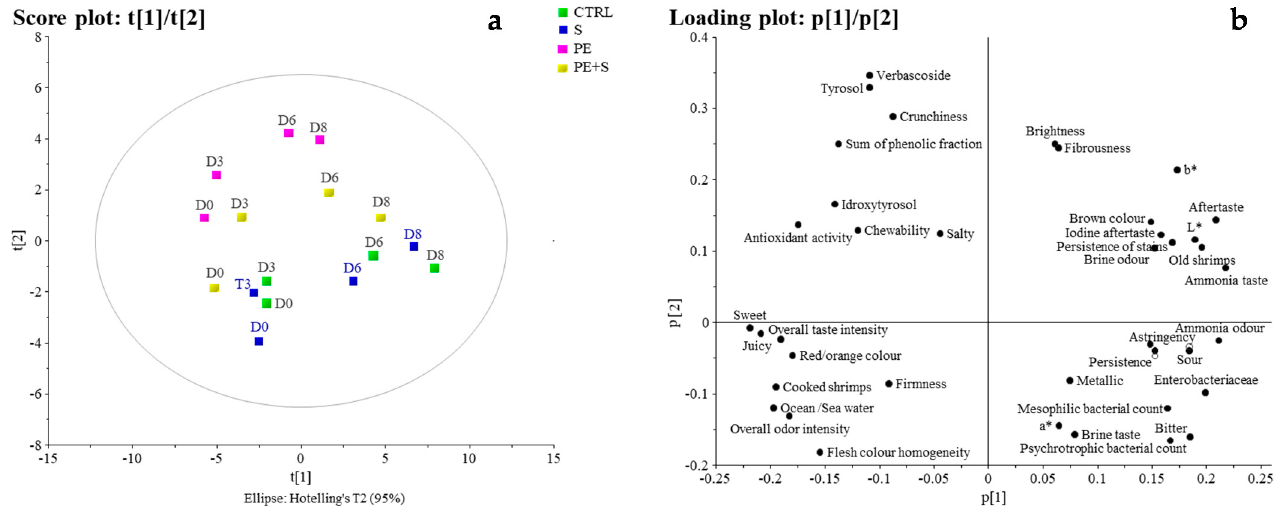
Figure 3. Score ( a ) and loading plot ( b ) of the PCA model built with all the samples and variables. The model with three significant principal components explains 68% of the variance of the data (46%, 13%, and 9%).